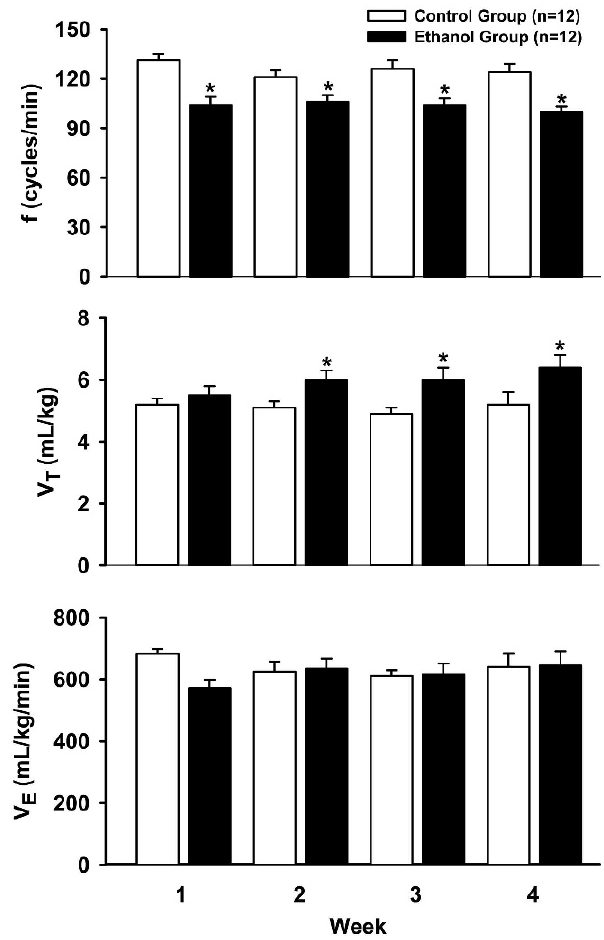
Figure 1 - Baseline values of respiratory frequency (f, top), tidal volume (V T , middle) and minute ventilation (V E , bottom) in rats receiving water (control group) or ethanol (ETOH) in increasing concentrations (first week: 5% v/v, second week: 10% v/v, third and fourth weeks: 20% v/v). Values are expressed as the mean ¡ SEM. *, p , 0.05 (two-way ANOVA) compared to control